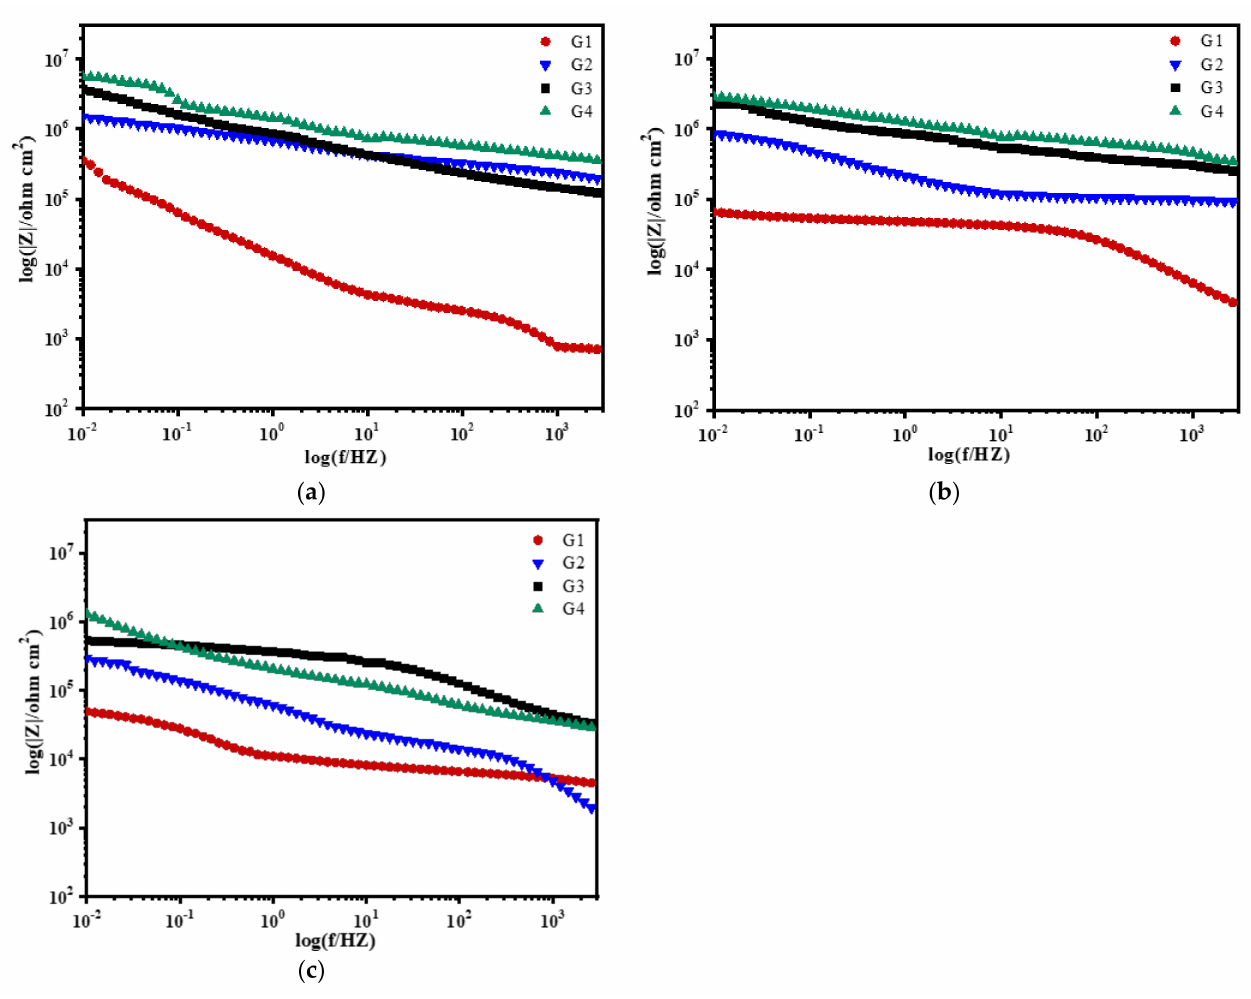
Figure 9. Each coating’s Bode pattern for immersion for 30 days: ( a ) 20% Seawater; ( b ) 40% Seawater; ( c ) 60%